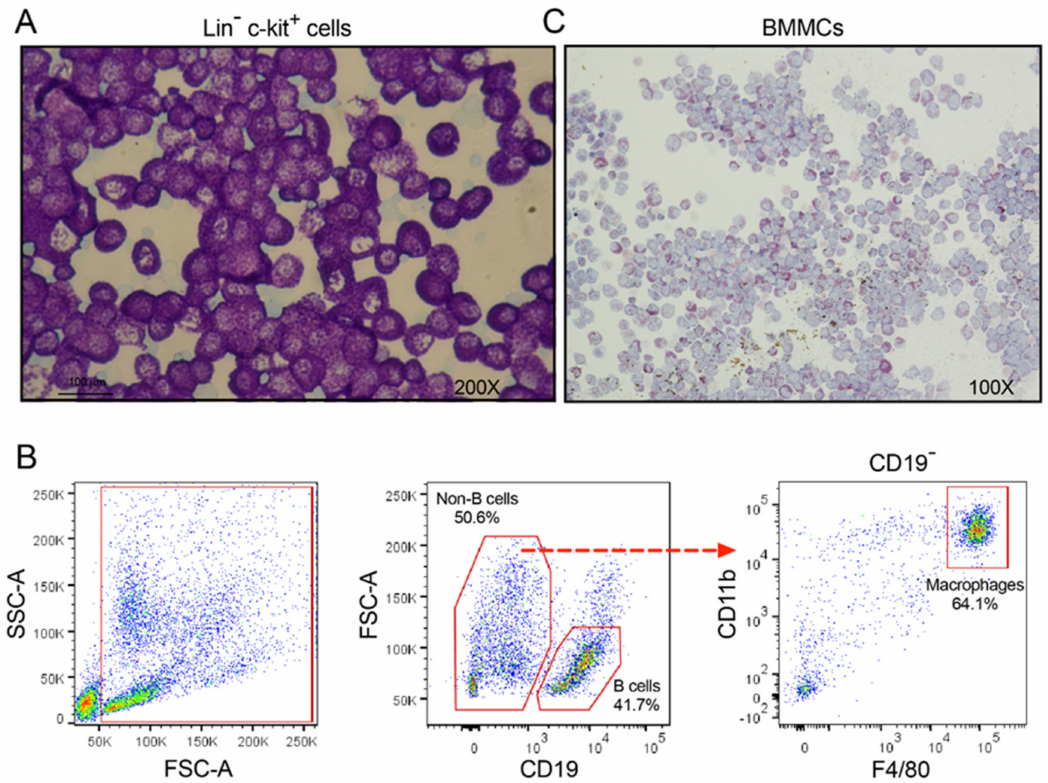
Figure 1. Freshly isolated peritoneal mast cells, B cells and macrophages as well as in vitro-di ff erentiated mast cells. ( A ) A representative image of freshly sorted peritoneal mast cells. Through MACS negative selection, lineagenegative(CD3 − , CD4 − , CD8 − , CD11b − , CD19 − , B220 − , Gr-1 − andTER-119 − )peritoneal cells were obtained and subsequently subjected to positive selection using MACS c-kit Micro Beads. The obtained Lin − c-kit + cells gave rise to more than 95% pure toluidine blue-positive mast cells. ( B ) Representative gating strategy used for sorting of peritoneal B (CD19 + ) cells and macrophages (CD19 − CD11b hi F4 / 80 hi ) by flow cytometry. After excluding debris in the first gate (FSC-A vs. SSC-A), doublet cells were also excluded using FSC-A vs. FSC-H and SSC-A vs. SSC-H plots (not shown). ( C ) A representative image of toluidine blue-stained bone marrow-derived mast cells (BMMCs) after growing in the presence of WEHI-3B-conditoned medium and recombinant IL-3 for four